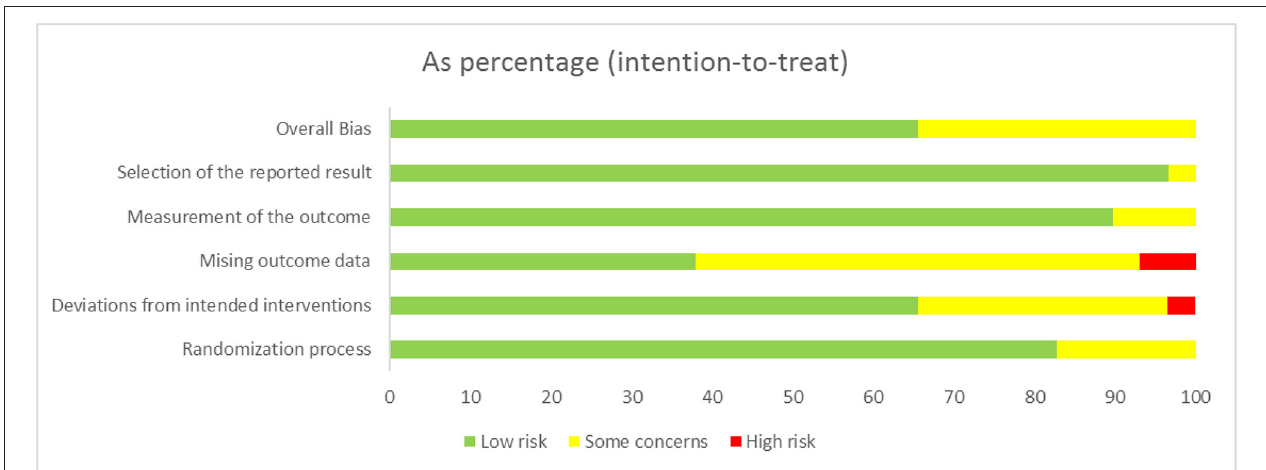
FIGURE 4 | Quality assessment